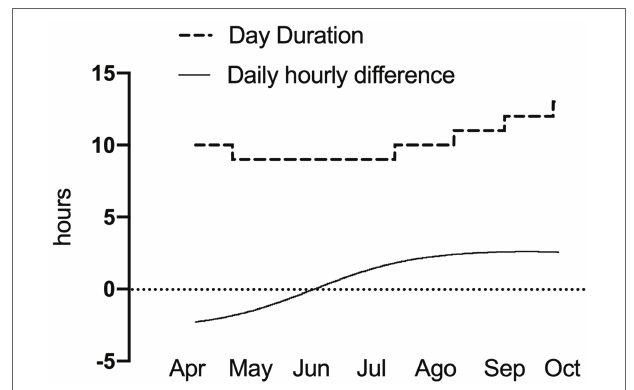
FIGURE 3 | Natural photoperiodic changes during the study period in the outdoor